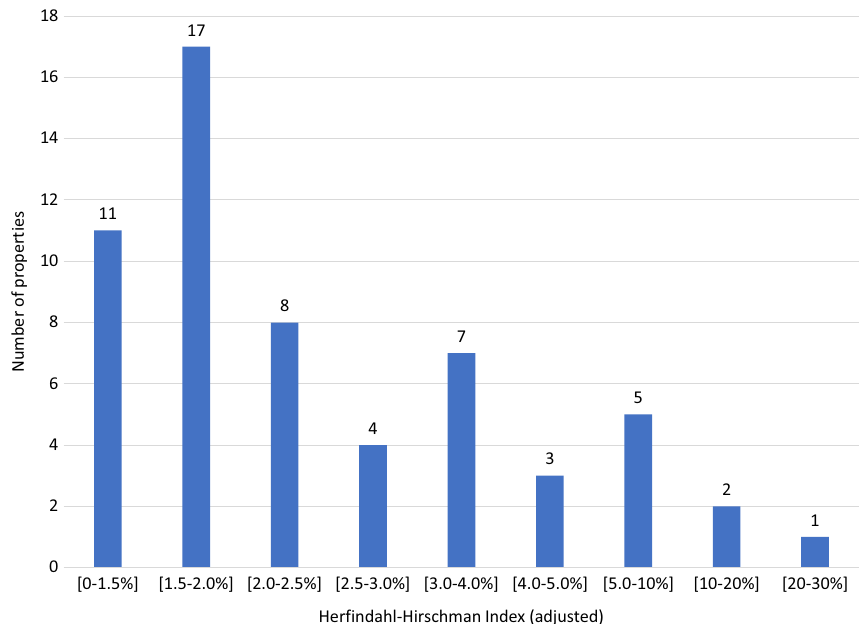
Table 2 Explaining dispersion of ownership Intercept 382.2 7.52* Token amount (NUM) 0.015 1.12 0.0012 1.45 Property value (VAL) 0.00040 2.72* Days since listed (AGE) DETROIT dummy R-square (adj.) 0.792 Statistical significance at the 5% level indicated with a *